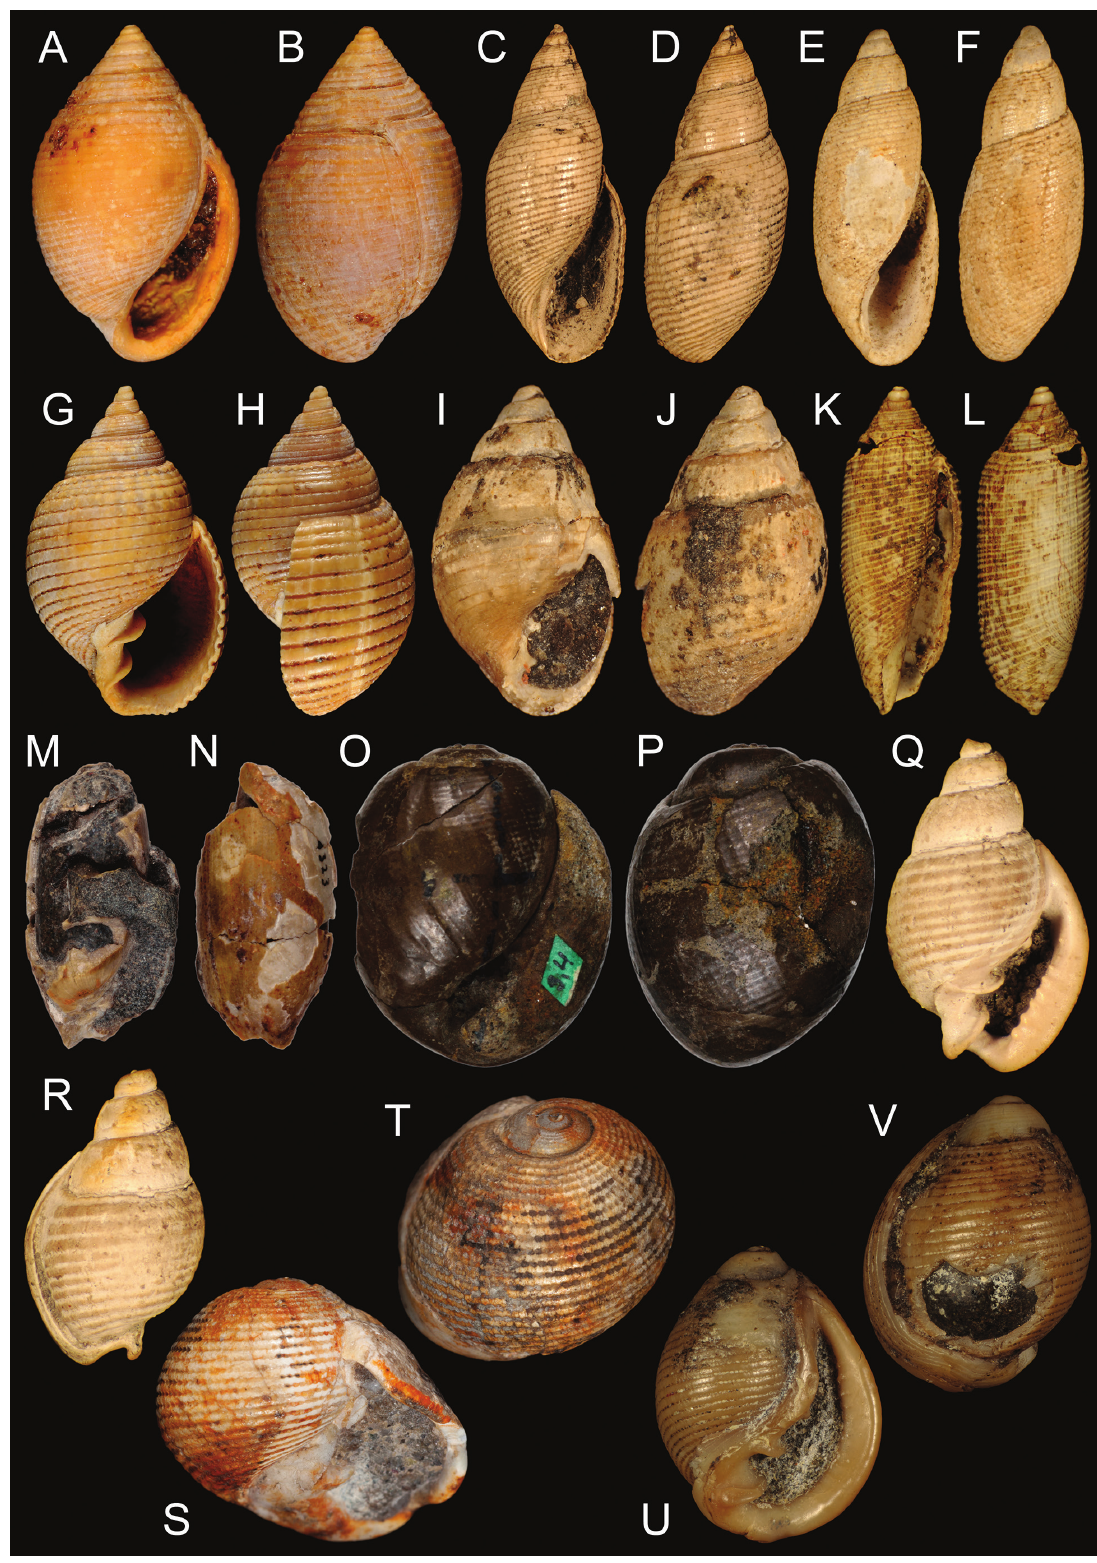
Figure 3. Types. A–B. Lectotype of Nucleopsis subvaricatus , H 10.8 mm, ANSP IP30692. C–D. Holotype of Rictaxis andersoni , H 10.5 mm, ANSP IP13411. E–F. Syntype of Rictaxis oryza , H 6.8 mm, ANSP IP3181. G–H. Lectotype of Tornatellaea bella , H 12.5 mm, ANSP IP30691. I–J. Lectotype of Tornatellaea impressa , H 10.7 mm, ANSP IP4286. K–L. Holotype of Volvaria reticulata , H 7.2 mm, ANSP IP6467. M–N. Holotype of Acteonella oviformis , H 42.1 mm, ANSP IP4323. O–P. Syntype of Avellana bullata , H 25.4 mm, ANSP IP289. Q–R. Syntype of Avellana costata , H 4.5 mm, ANSP IP691. S–T. Lectotype of Biplica obliqua , H 9.9 mm, ANSP IP4263. U–V. Lectotype of Biplica mathewsonii , H 11.6 mm, ANSP